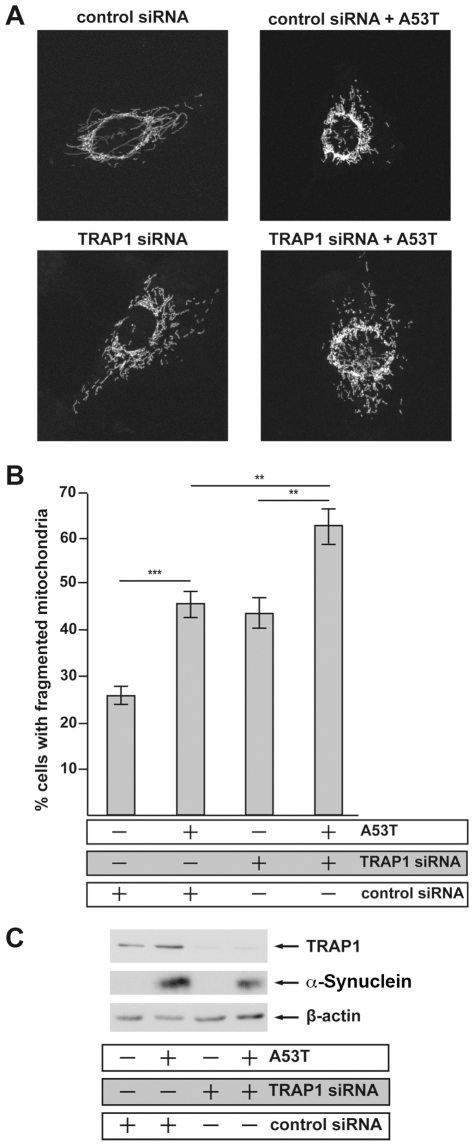
Transient siRNA-mediated knockdown of TRAP1 increases [A53T]α-Synuclein-induced mitochondrial fragmentation.SH-SY5Y cells were co-transfected with the siRNAs and plasmids indicated. Mitochondria were visualized by DsRed targeted to mitochondria (mito-DsRed). (A) Confocal images taken of representative cells displaying either an intact tubular mitochondrial network (control siRNA) or a fragmentation of the network (control siRNA+A53T). Transient knockdown of TRAP1 causes mitochondrial fragmentation itself (TRAP1 siRNA), additional co-expression of [A53T]α-Synuclein aggravated this phenotype and led to an overall increase in cells showing a fragmented mitochondrial network (TRAP1 siRNA+A53T). (B) For quantification, at least 300 transfected cells per coverslip were analyzed. The mitochondrial morphology was determined in a blinded manner. Quantifications are based on triplicates of three independent experiments. (C) Expression levels of [A53T]α-Synuclein and TRAP1 were analyzed by Western Blotting. β-Actin was used as a loading control. **p<0.01; ***p<0.001 (ANOVA).